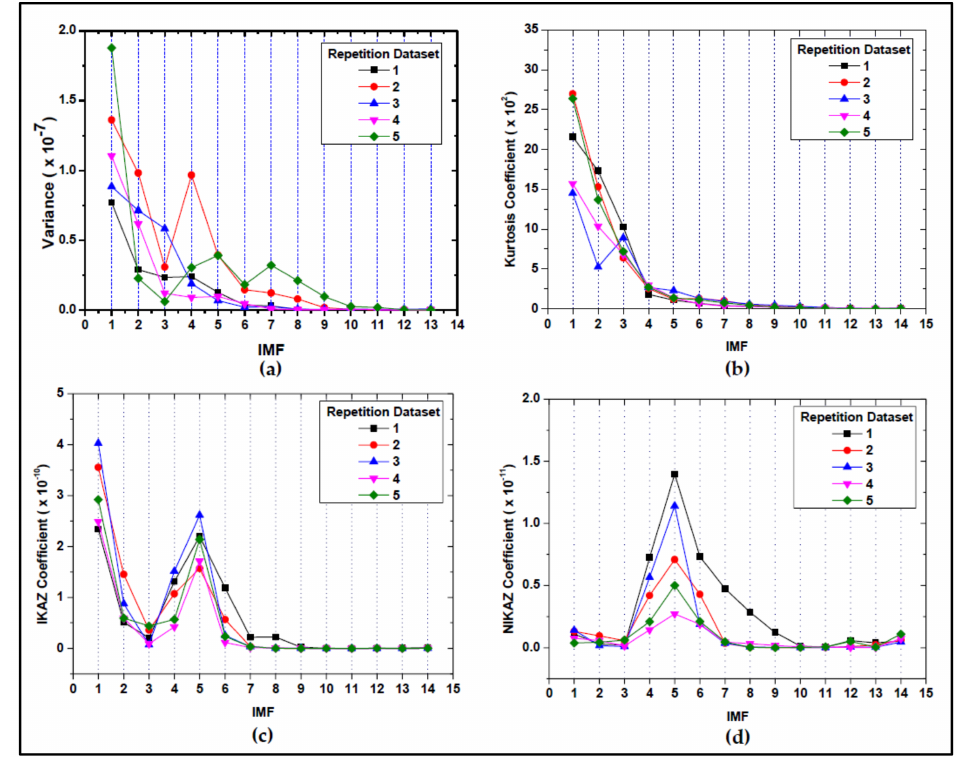
Figure 17. The curve for 5 mm leak IMFs induced on fire hydrant 2: ( a ) Variance, ( b ) Kurtosis, ( c ) IKAZ, ( d )